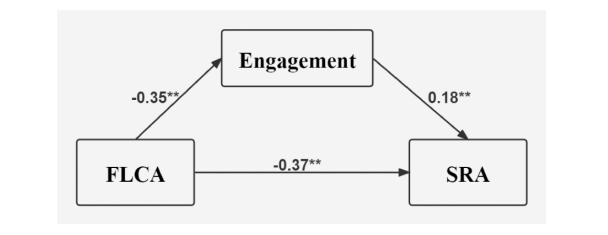
FIGURE 2 | The mediation model 2. All are standardized coefficients, ** p < 0.01, FLCA, foreign language classroom anxiety; SRA, self-reported